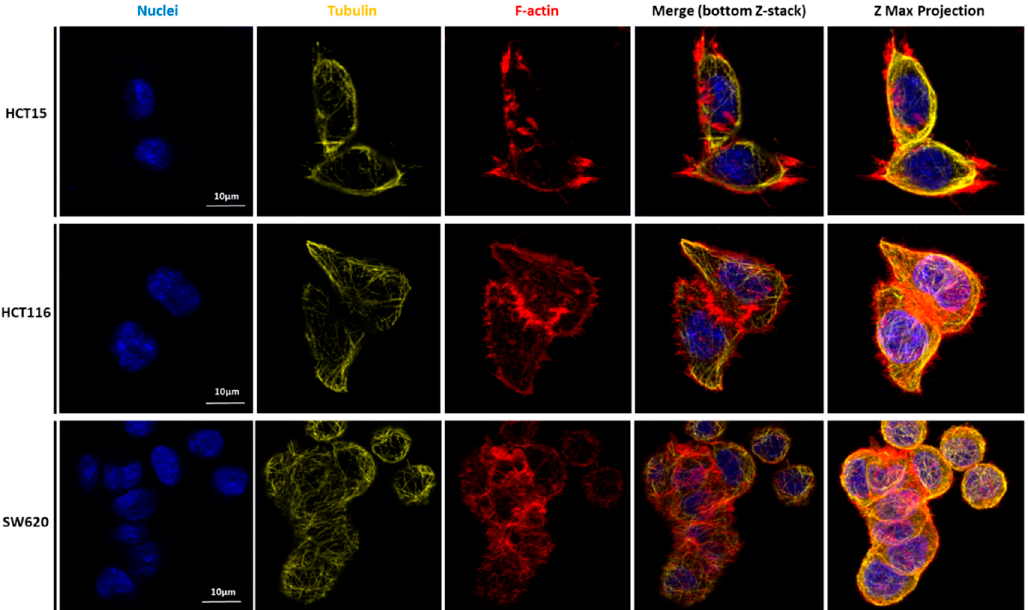
Figure 6. Expression of tubulin and F-actin in CRC cells. Staining of HCT15 ( top ), HCT116 ( middle ), and SW620 ( lower images ) cells for DAPI to localize the nuclei (blue), tubulin (yellow), and phalloidin to detect F-actin filaments (red). The bottom Z-stack is shown, and a Z-maximum projection of each condition is also depicted ( right panels ). Scale bars: 10 µm.